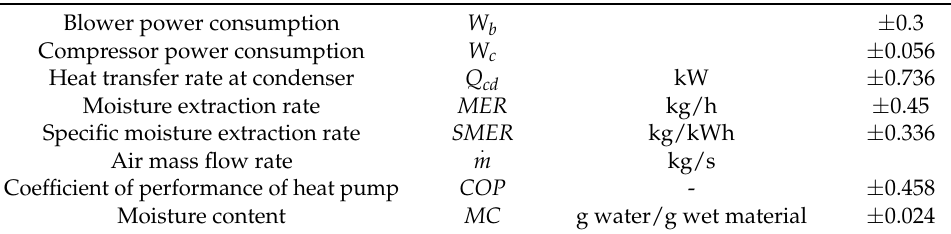
Table 2. Uncertainty of mean values of measured and calculated parameters.